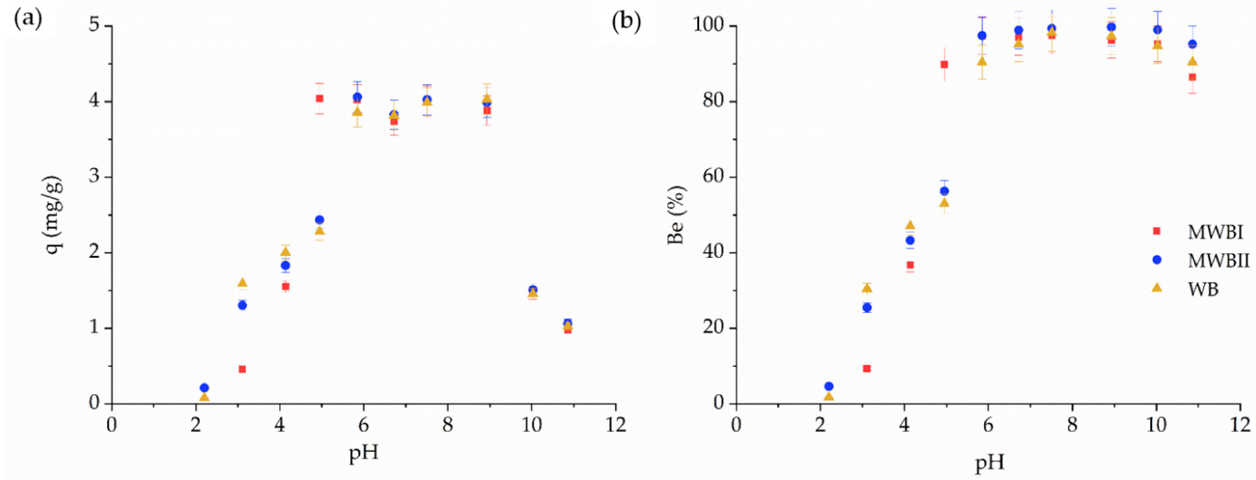
Figure 4. Effect of pH on Be sorption from aqueous solution using the MWBI, MWBII and origin WB (2 mg/L Be; 6 h contact time, 0.1 g:50 mL sorbent dosage, 25 °C); ( a ) sorption capacity (in mg/g) and ( b ) removed amount (in %).